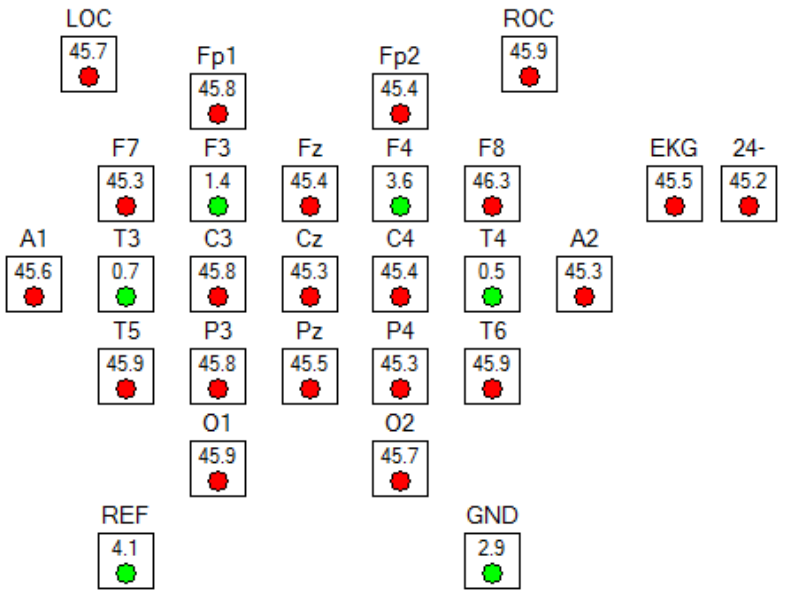
Figure 1. Electroencephalography electrode setup. Four conventional EEG recording sites were used in accordance with the international 10/20 system.